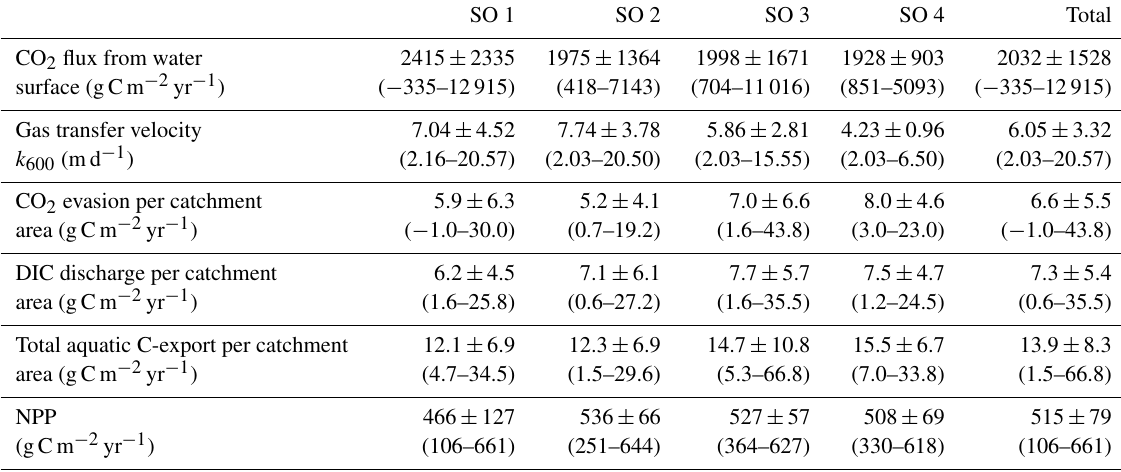
Table 2. Aquatic C-fluxes and terrestrial NPP in catchments drained by streams of different stream orders (SO) and for all sampling sites (Total). All values are mean ± standard deviation and ranges are given in brackets. The CO 2 flux from the water surface (first row) is expressed per square meter water surface area, while the remaining fluxes are expressed per square meter catchment